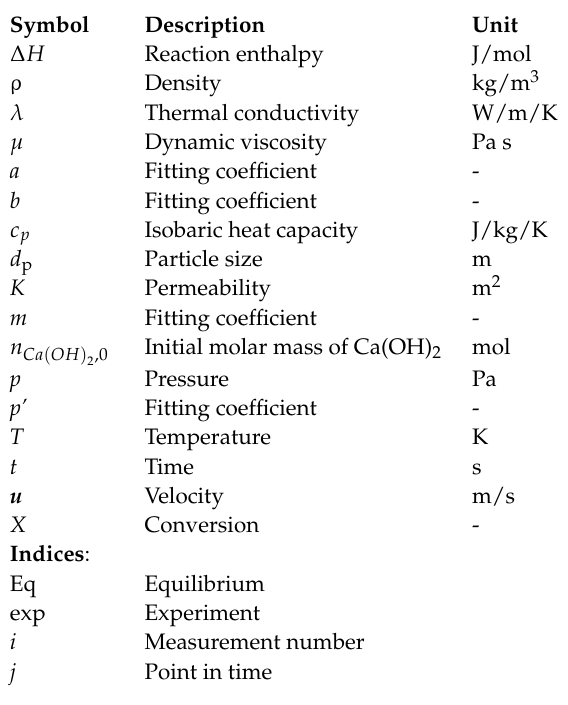
Figure S3: Experimental and numerical results for E5; Figure S4: Experimental and numerical results for E9; Figure S5: Comparison of the bulk before and after the experiments; Figure S6: Simulation with an assumed permeability increase by the factor 100 for E11 and E13; Figure S7: Variation of the thermal conductivity, the reaction rate, and the permeability for